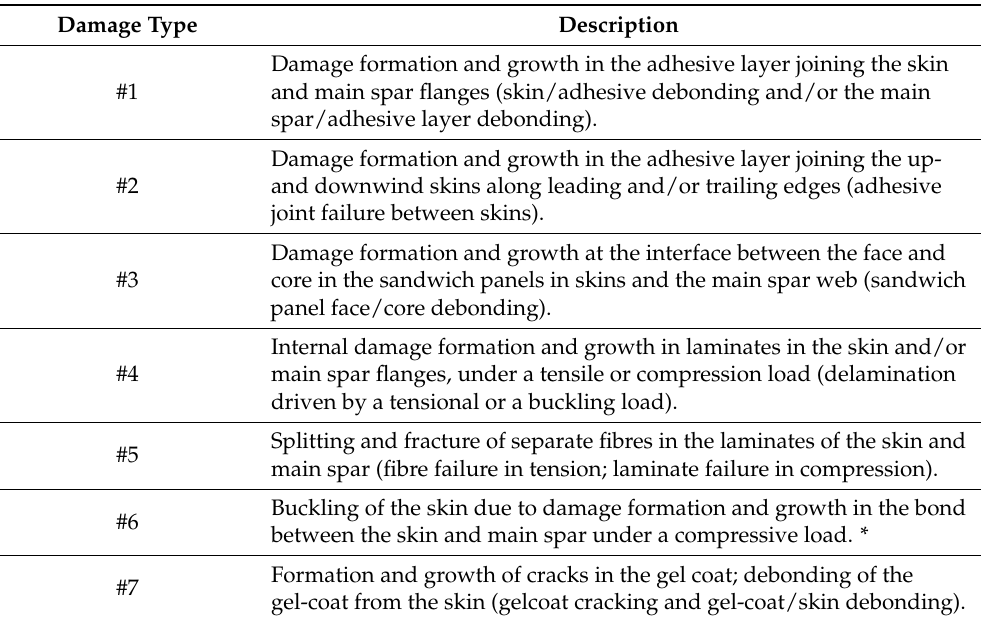
Table 1. Typical damage typologies in WT blades, according to Refs. [48,49]. Damage